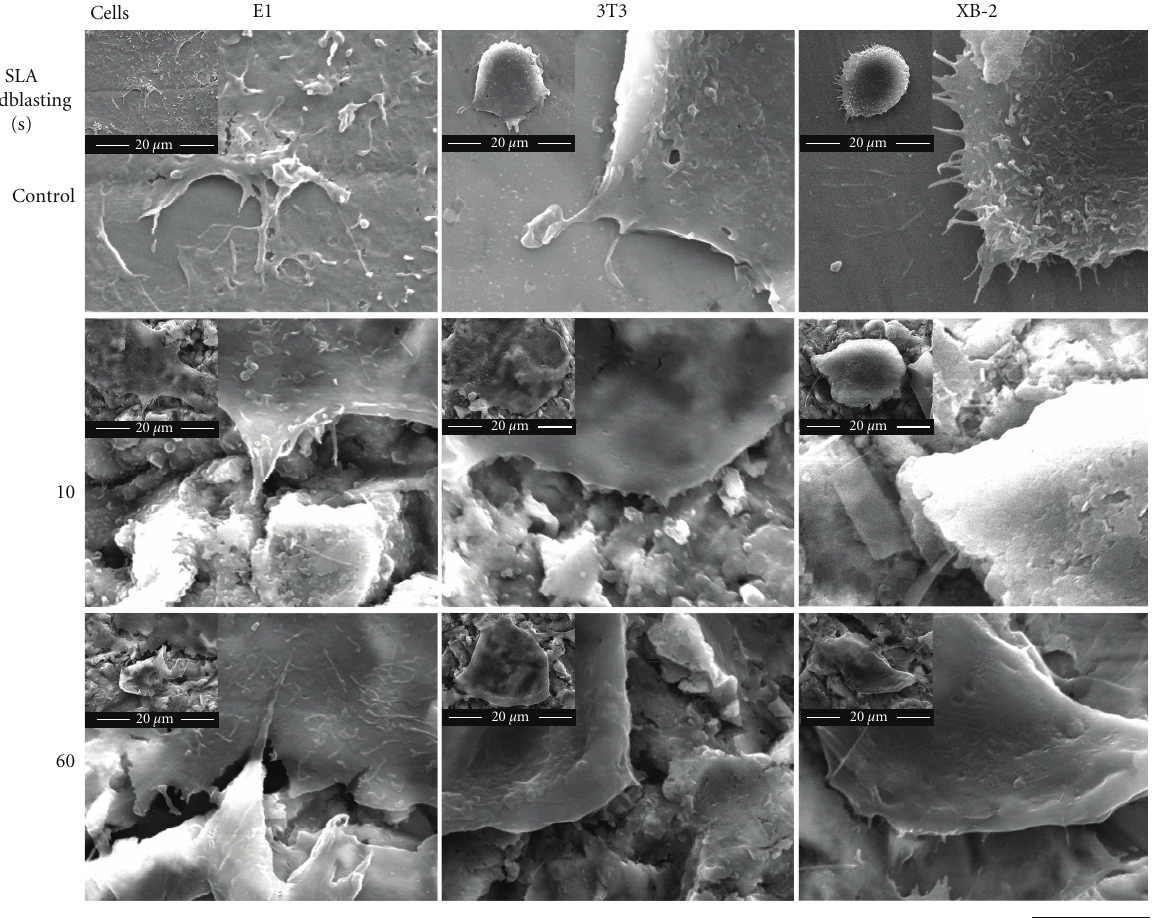
Figure 5: SEM images showing the proliferative morphologies of the various cells growing on areas of varying roughness in the control and test groups after 10, 30, and 60/30sec of blasting and etching after 24h.